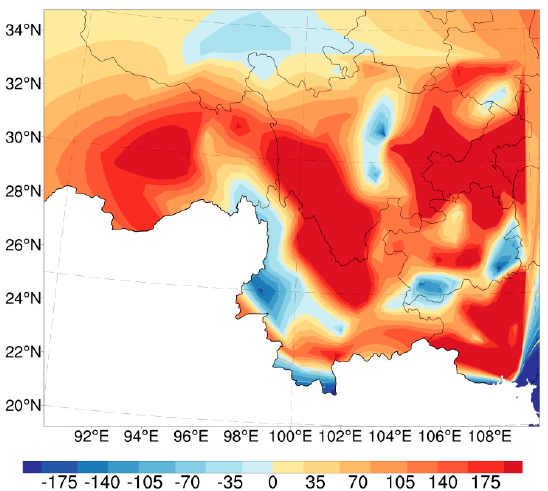
Figure 9. Spatial distribution of precipitation anomalies over southeast China during 1998. (Unit: millimeters, mm).